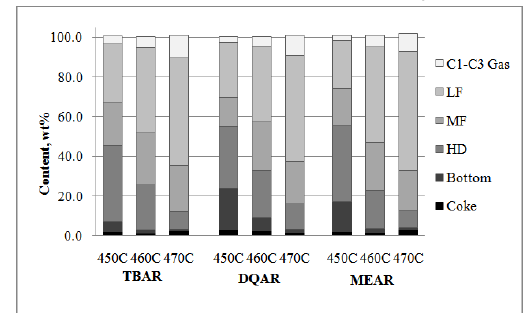
-C gases after 1 3